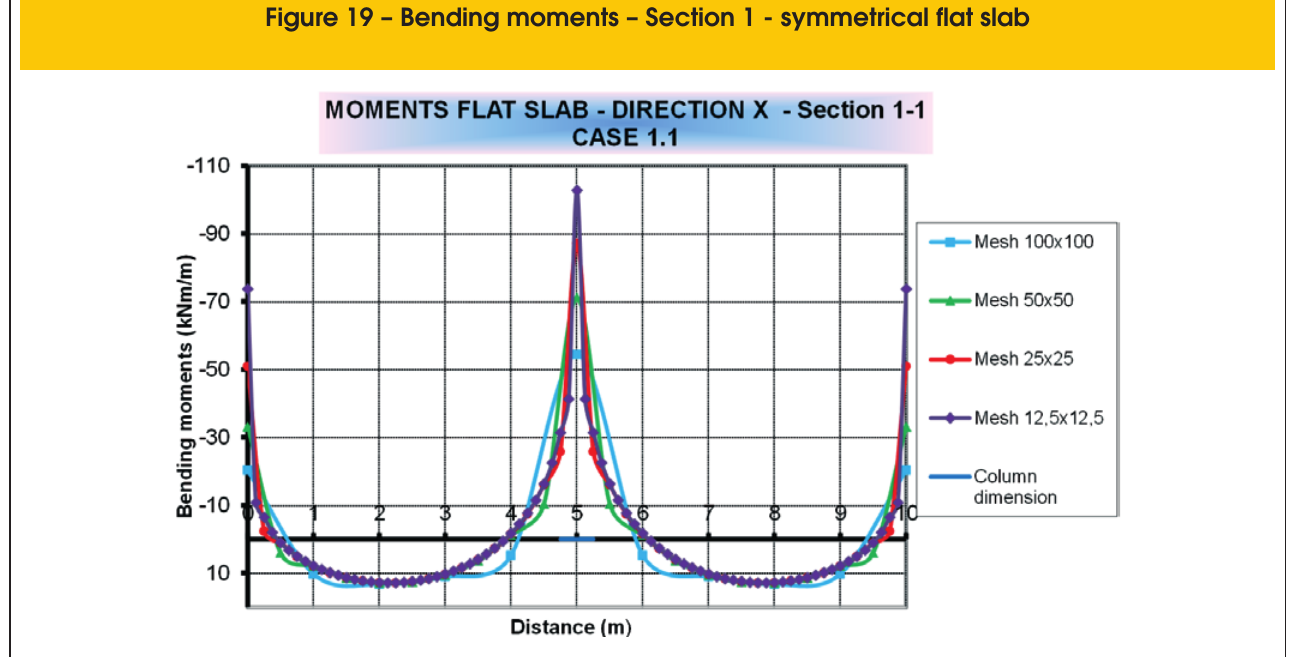
Figure 19 – Bending moments – Section 1 - symmetrical flat slab